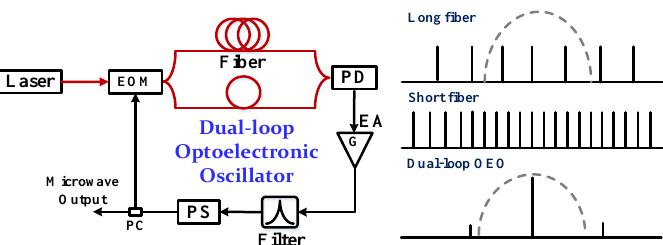
Figure 2. The schematic diagram of dual-loop optoelectronic oscillator. EOM: electro-optical modulator. PD: photodetector. EA: electronic amplifier. PS: phase shifter. PC: power coupler.